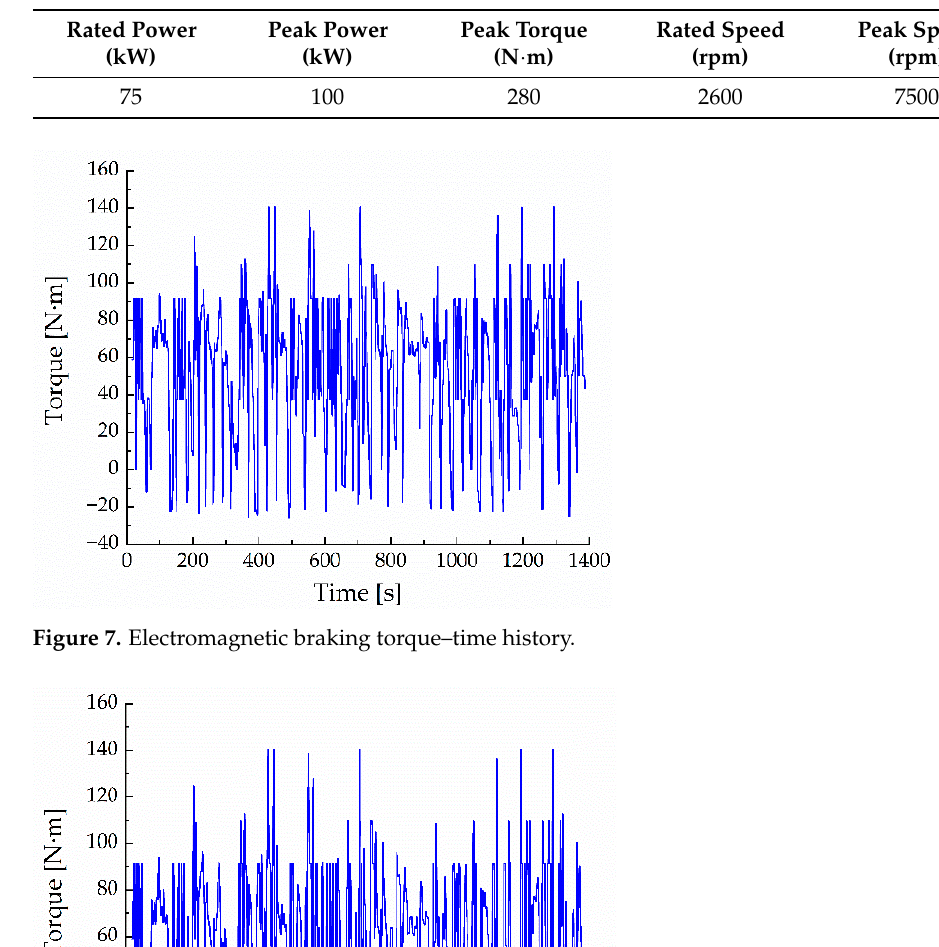
Table 3. Motor characteristics.